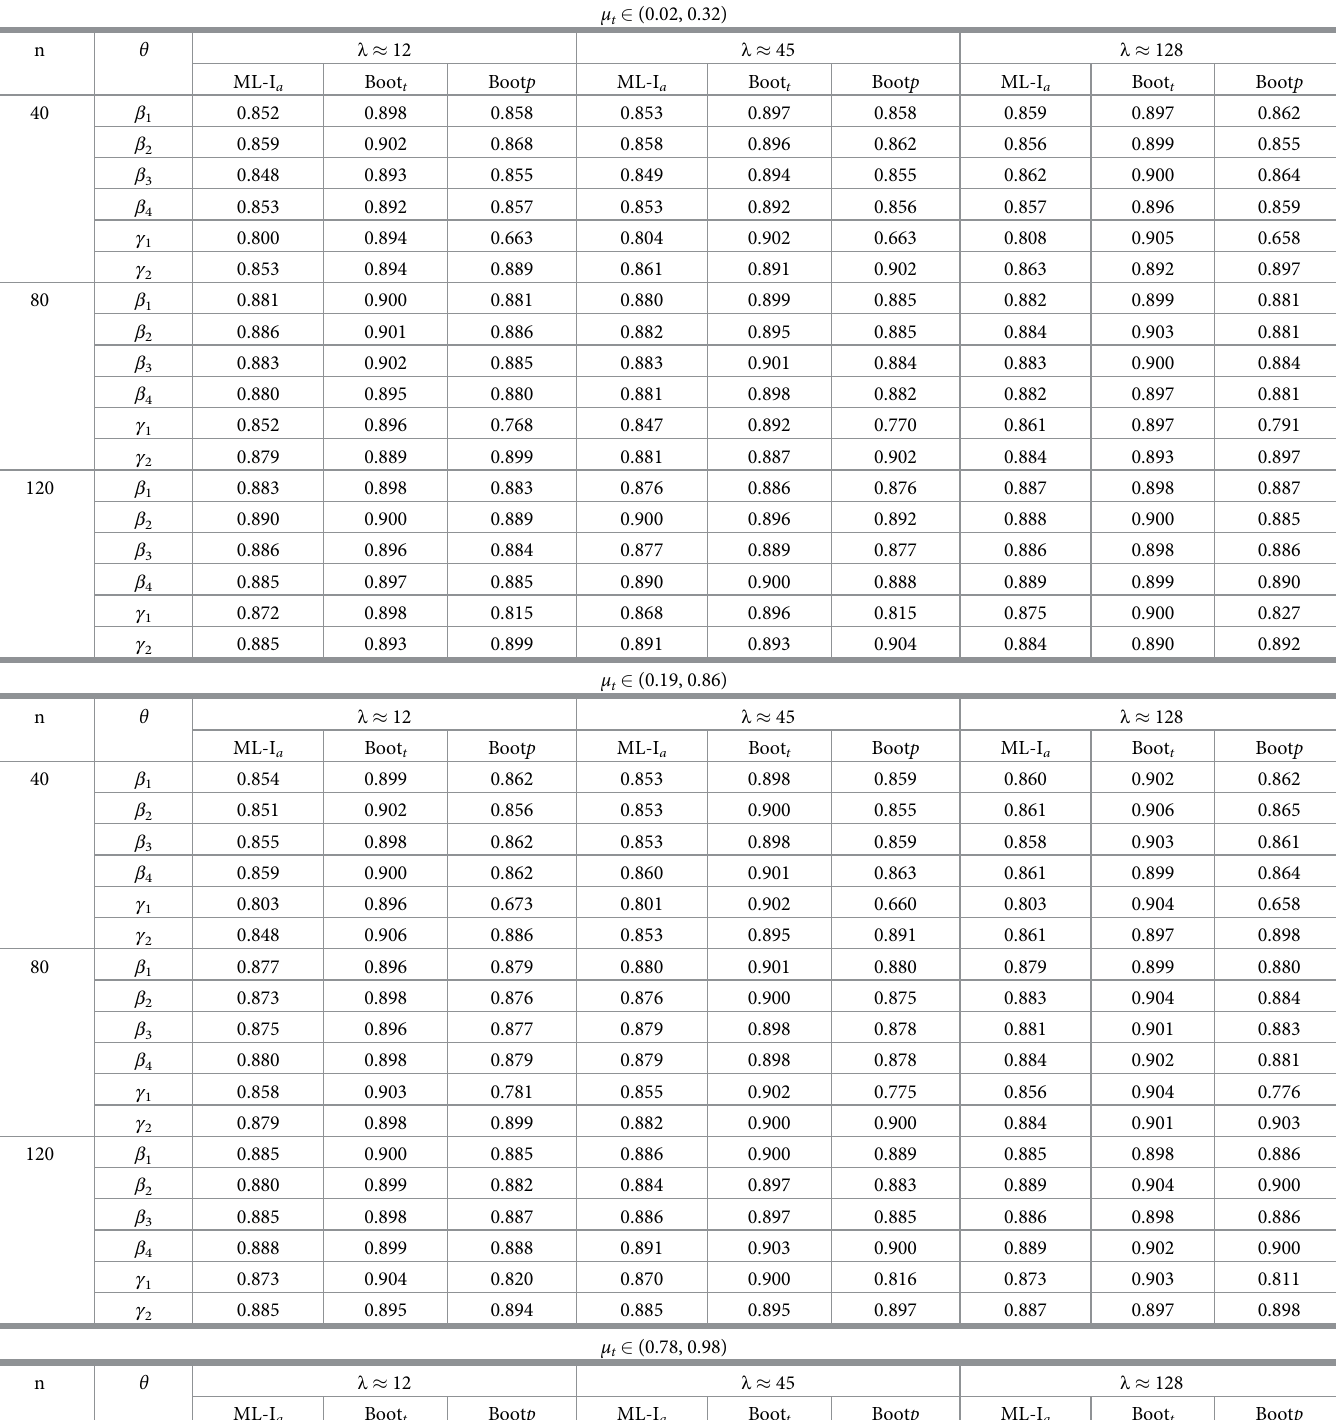
Table 4. Coverage rates of the interval estimators: ML-I log ð σ